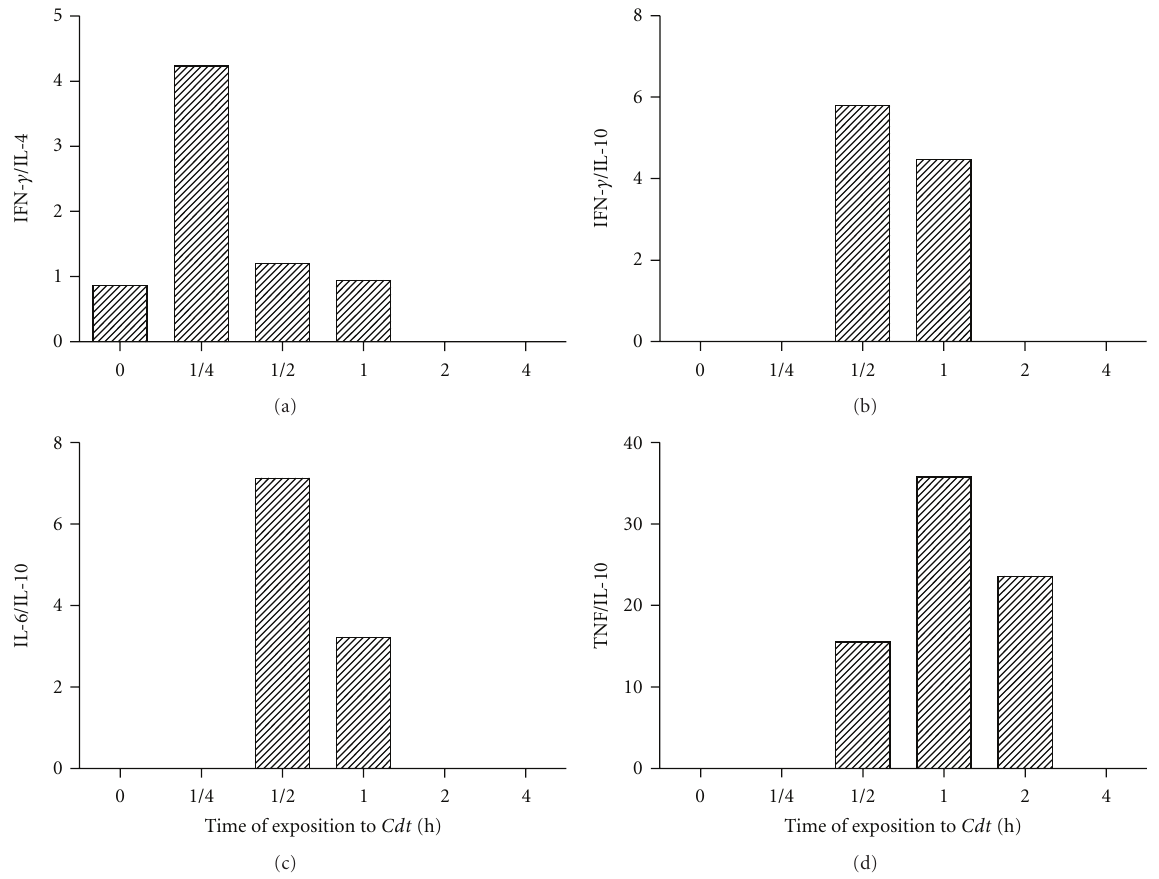
Figure 4: Balance pro-/anti-inflammatory. The urine levels of cytokines were determined as described in Section 2. The ratios IFN- γ /IL-4, IFN- γ /IL-10, IL-6/IL-10 and TNF/IL-10 represent the values of samples from two experiments in di ff erent groups of five mice.